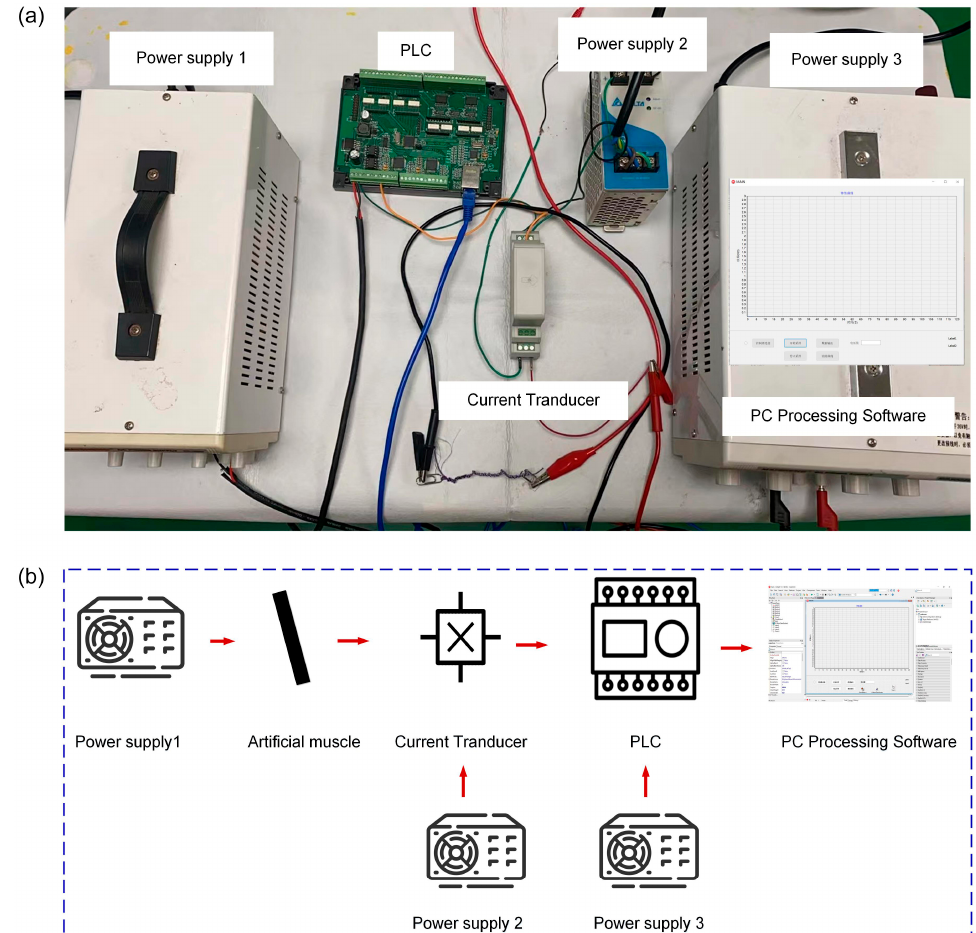
Figure 2. Real-time signal detection system. ( a ) Experimental setups of the signal detection system; ( b ) Schematic diagram of the signal detection system.